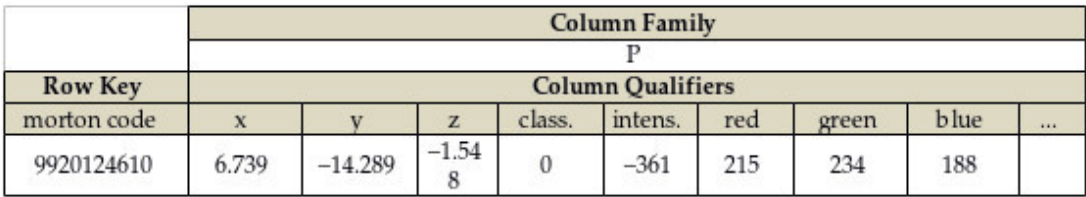
Figure 5. User define function ( UDF) over class point.